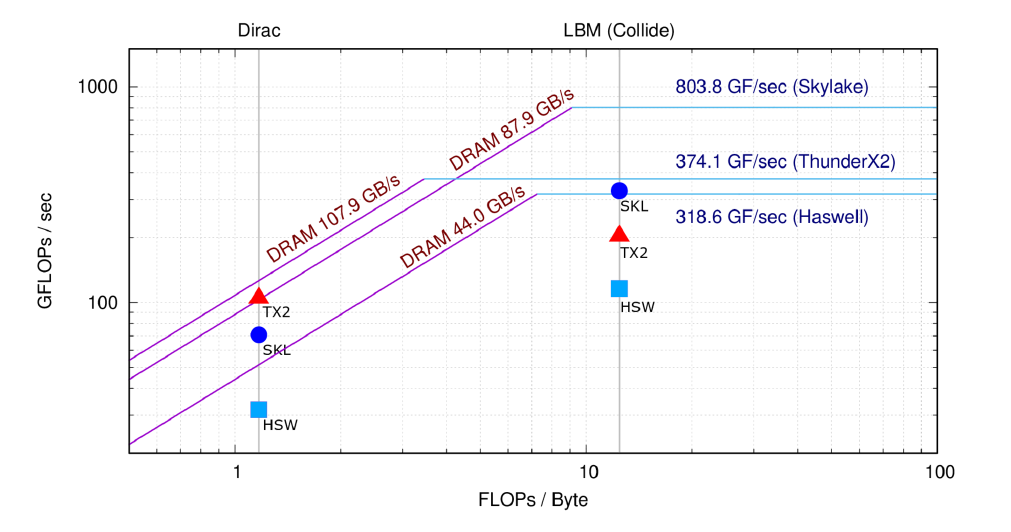
Figure 1. Empirical Roofline graphs for Intel Xeon Gold 6130 ( Skylake ), Intel Xeon E5-2630v3 ( Haswell ), and the Marvell TX2 measured using the ERT benchmark. Points represents performance obtained by Dirac (on the left) and LBM collide (on the right) kernels. Table 3. GCC optimization flags, in addition to -O3 , used, respectively, for the three target architectures.